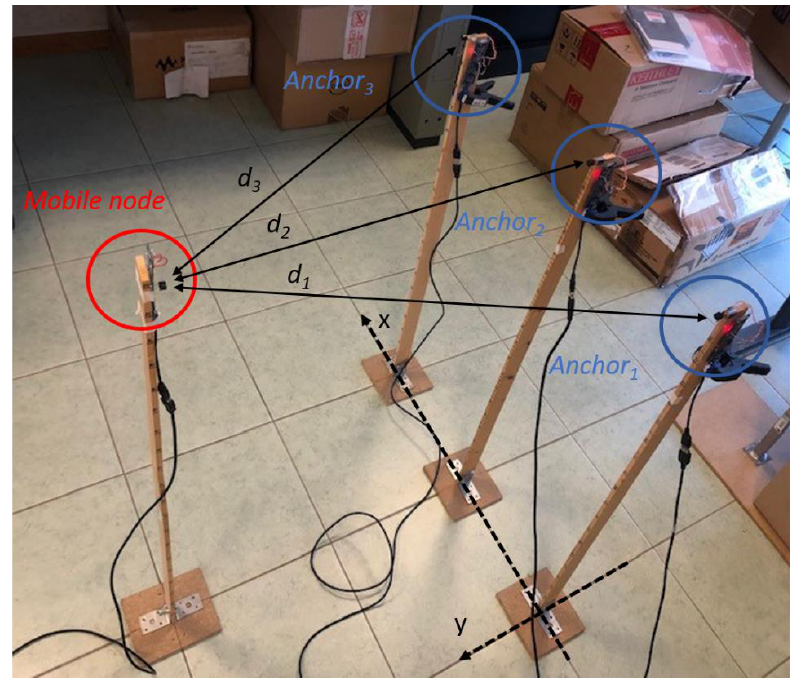
Figure 4. Picture of the experimental setup.